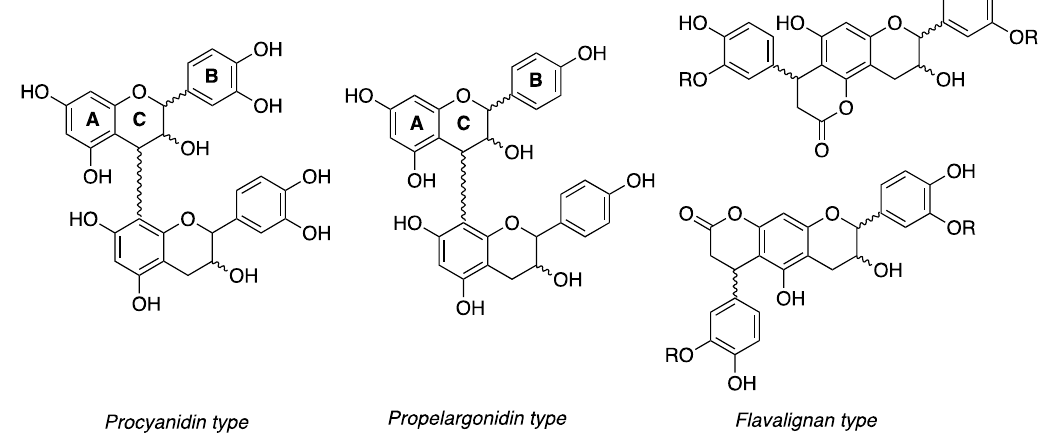
Figure 1. Procyanidin (PC), propelargonidin (PP), and flavalignans (FL) general chemical structures.